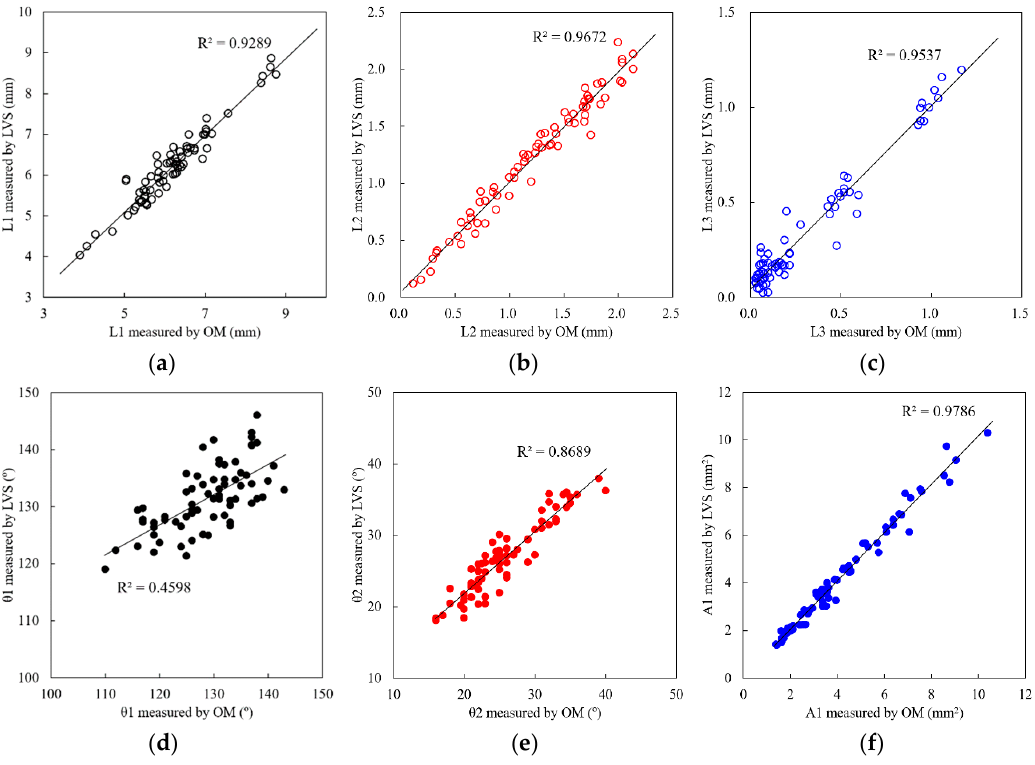
Figure 11. Comparison between LVS and optical microscopic (OM) measurements: ( a ) L1, ( b ) L2, ( c ) L3, ( d ) θ 1, ( e ) θ 2, and ( f ) A1. Table 5. Average errors of the various geometric